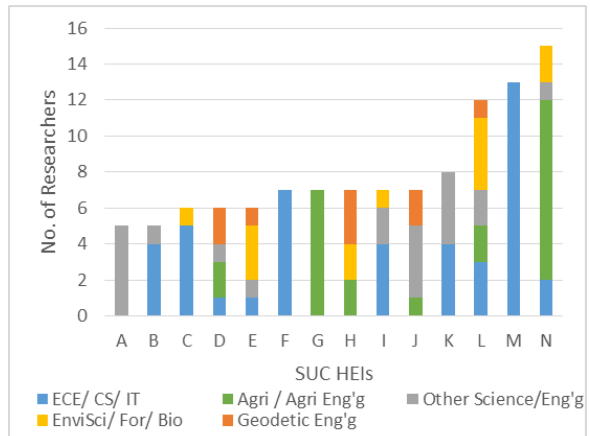
Figure 11. Researchers